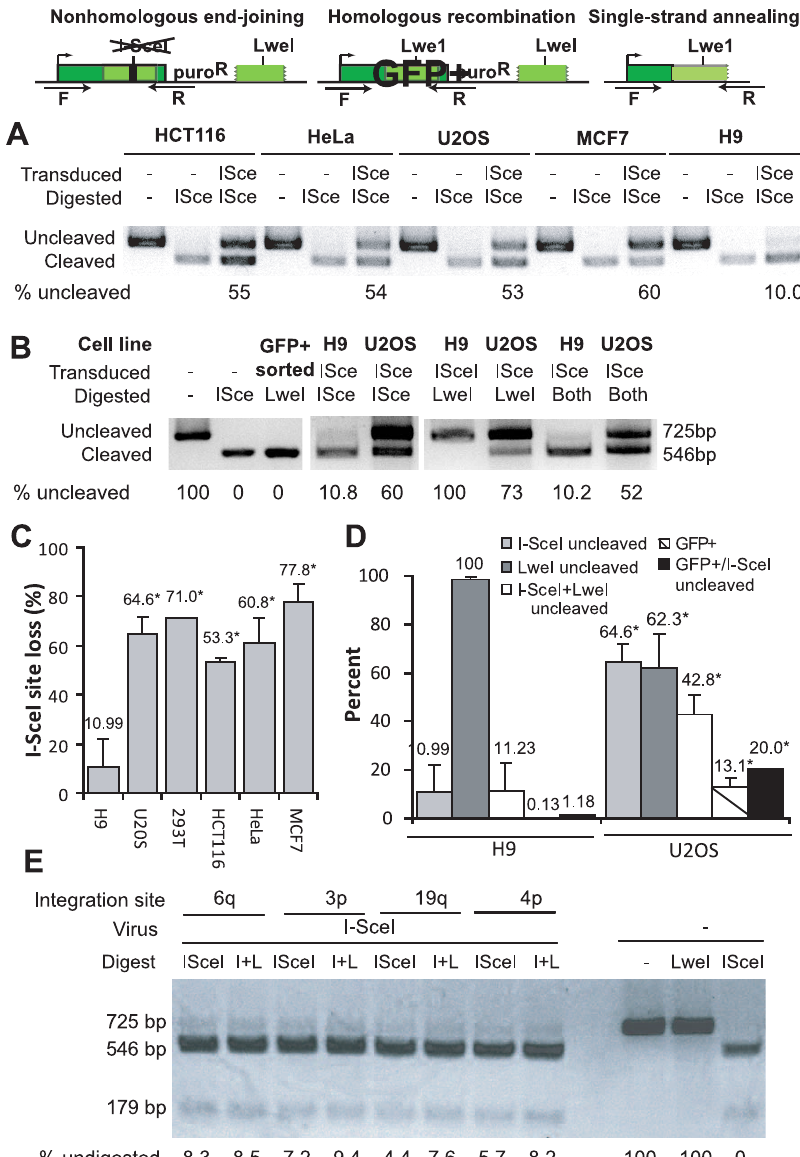
Figure 4. Repair through NHEJ, HR or SSA. A . Repair through imprecise NHEJ results in ‘‘loss’’ of the I-SceI site while repair through HR or SSA replaces the I-SceI site with an LweI site. DNA was isolated 96 hours after I-SceI transduction. After PCR amplification with the F and R primers and digestion with I-SceI, the uncleaved band (725 bp) represents product from cells that have undergone imprecise repair through any of the three pathways. B . Digestion of the PCR product with LweI generates a cleaved band (546 bp) that represents product from cells that have undergone HR or SSA. After digestion with both I-SceI and LweI (indicated as ‘‘Both’’), the uncleaved band represents product from cells that have repaired by imprecise NHEJ. ‘‘GFP + ’’ indicates an I-SceI transduced population that was sorted to be 100% GFP-positive, which served as a control for LweI digestion. C . Comparison of the fractions of uncleaved product after PCR amplification and I-SceI digestion. * indicates p , 0.01 compared with H9. Error bars indicate one standard deviation. D . Comparison of the fractions of uncleaved product after digestion with the indicated enzymes. ‘‘GFP + ’’ values are from flow cytometry after I-SceI transduction (Figure 3B). E . PCR product obtained from H9 hESC clones with non-targeted DR-GFP 96 hours after I-SceI transduction was digested with I-SceI, LweI or both (indicated as ‘I + L’). Untransduced cells are included to demonstrate complete digestion with I-SceI enzyme.